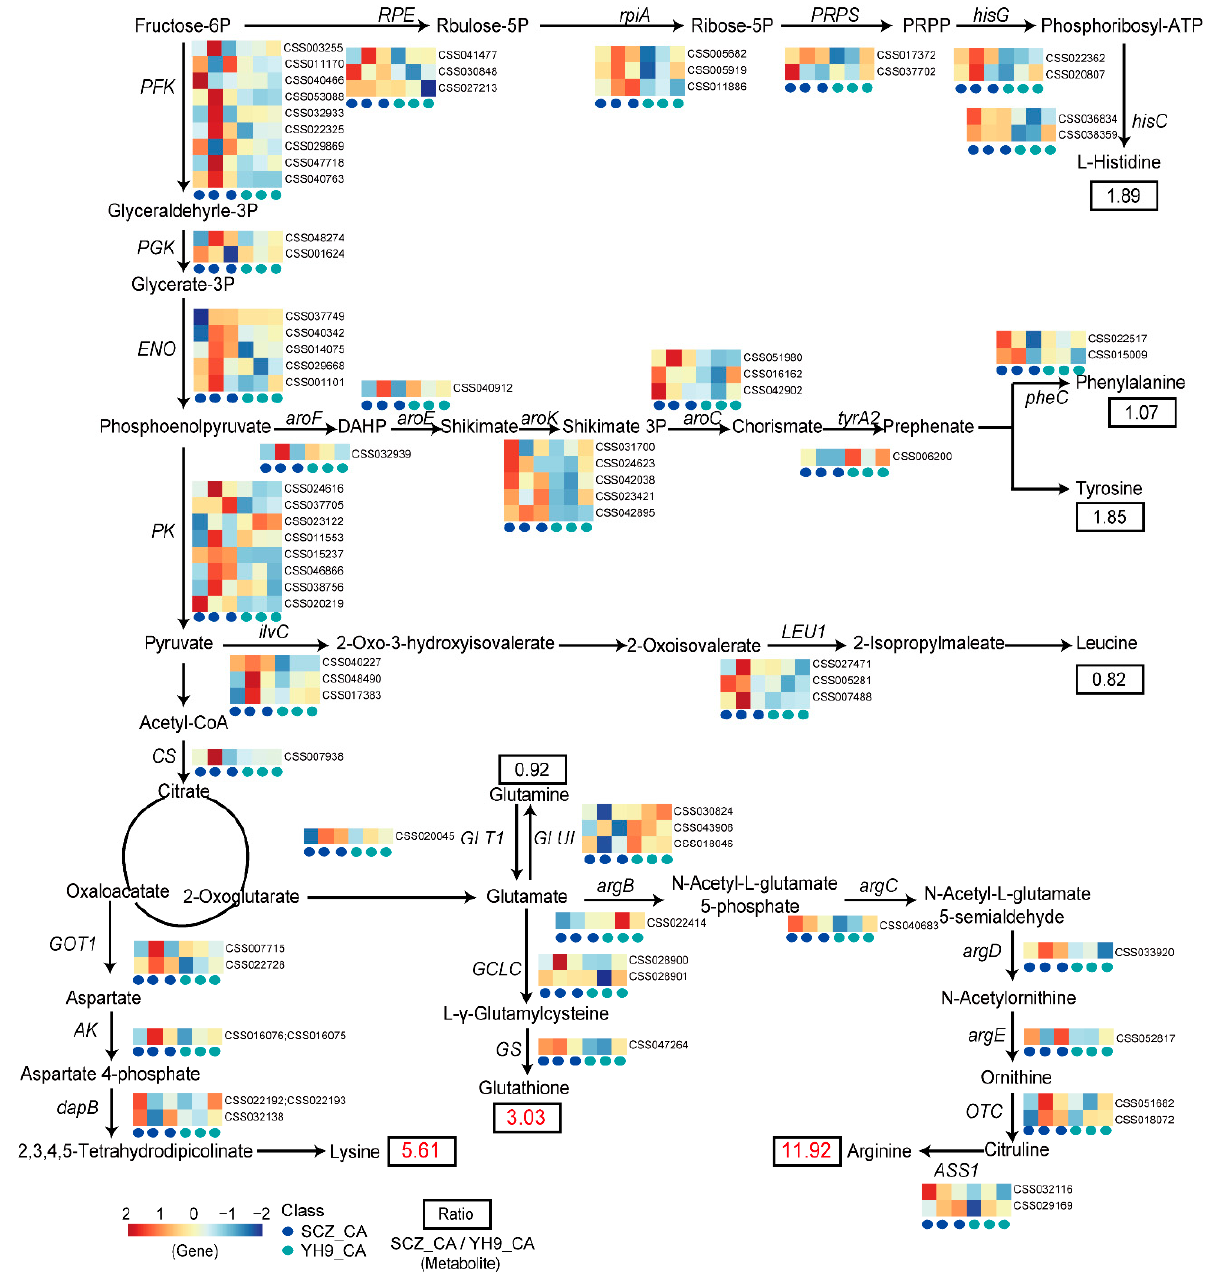
Figure 5. Amino acid biosynthesis pathways in SCZ and YH9 at CA stage. PFK, 6 − phosphofructo- kinase 1; PGK, phosphoglycerate kinase; ENO, enolase; PK, pyruvate kinase; CS, citrate synthase; RPE, ribulose − phosphate 3 − epimerase; rpiA, ribose 5 − phosphate isomerase; PRPS, ribose − phos- phate pyrophosphokinase; hisG, ATP phosphoribosyltransferase; aroF, 3 − deoxy − 7 − phosphohep- tulonate synthase; aroE, shikimate dehydrogenase; aroK, shikimate kinase; aroC, chorismate syn- thase; tyrA2, prephenate dehydrogenase; pheC, cyclohexadienyl dehydratase; ilvC, ketol-acid re- ductoisomerase; LEU1, 3 − isopropylmalate dehydratase; GOT1, aspartate aminotransferase; AK, as- partate kinase; dapB, 4 − hydroxy-tetrahydrodipicolinate reductase; GLT1, glutamate synthase; GLUL, glutamine synthetase; GCLC, glutamate − cysteine ligase catalytic subunit; GS, glutathione synthase; argB, acetylglutamate kinase; argC, N − acetyl − gamma − glutamyl − phosphate reductase; argD, acetylornithine aminotransferase; argE, acetylornithine deacetylase; OTC, ornithine car- bamoyltransferase; ASS1, argininosuccinate synthase. The heat map was drawn using the Z − score conversion value of transcriptome data. The color scale shows increasing expression levels from blue to red.